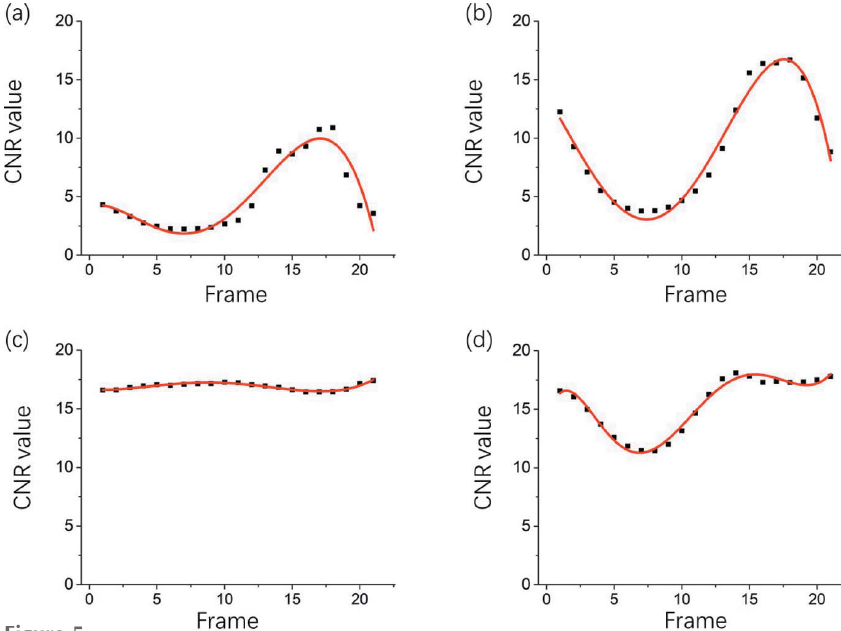
Figure 5 CNR of the retrieved images versus frames obtained continuously after injection of contrast agent, where ( a ) indicates values obtained using the conventional temporal subtraction method and ( b ), ( c ), and ( d ) indicate values obtained using PTA with a window width of 9, 19, and 29,